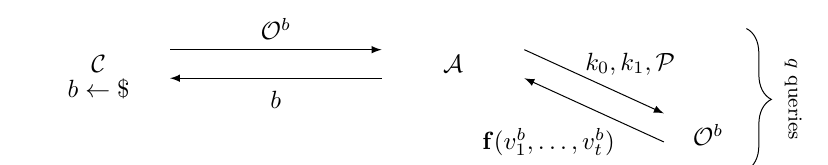
Figure 1: The privacy model for glitch-extended t -threshold-probing security consisting of a challenger C , an adversary A , a left-right oracle O b , two inputs k 0 , k 1 , a set of probes P , and a noisy leakage function f ( v b circuit C ( k b